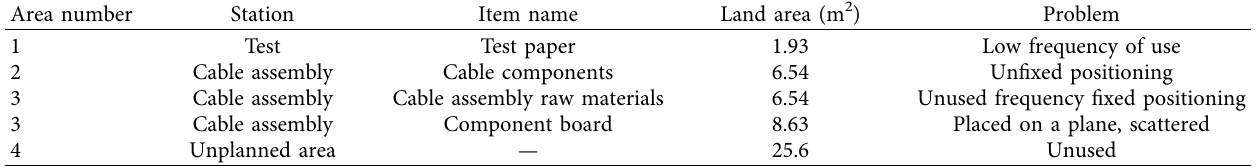
Table 2: Occupancy analysis of workshop.